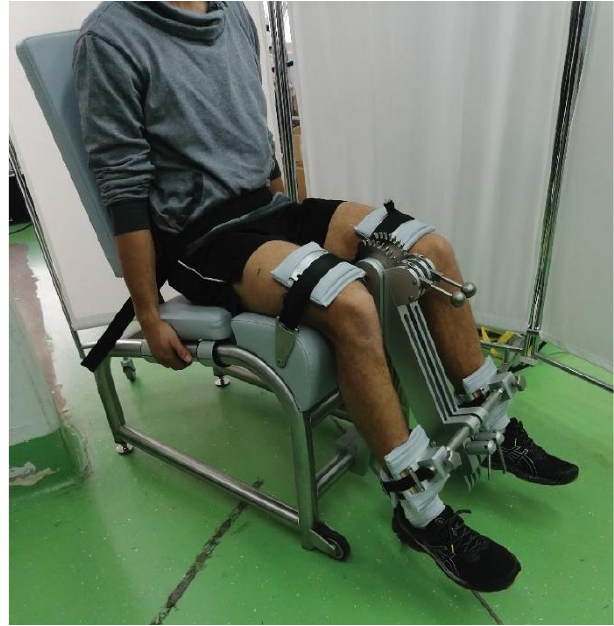
Figure 2. Set-up for maximal strength and endurance measurements.